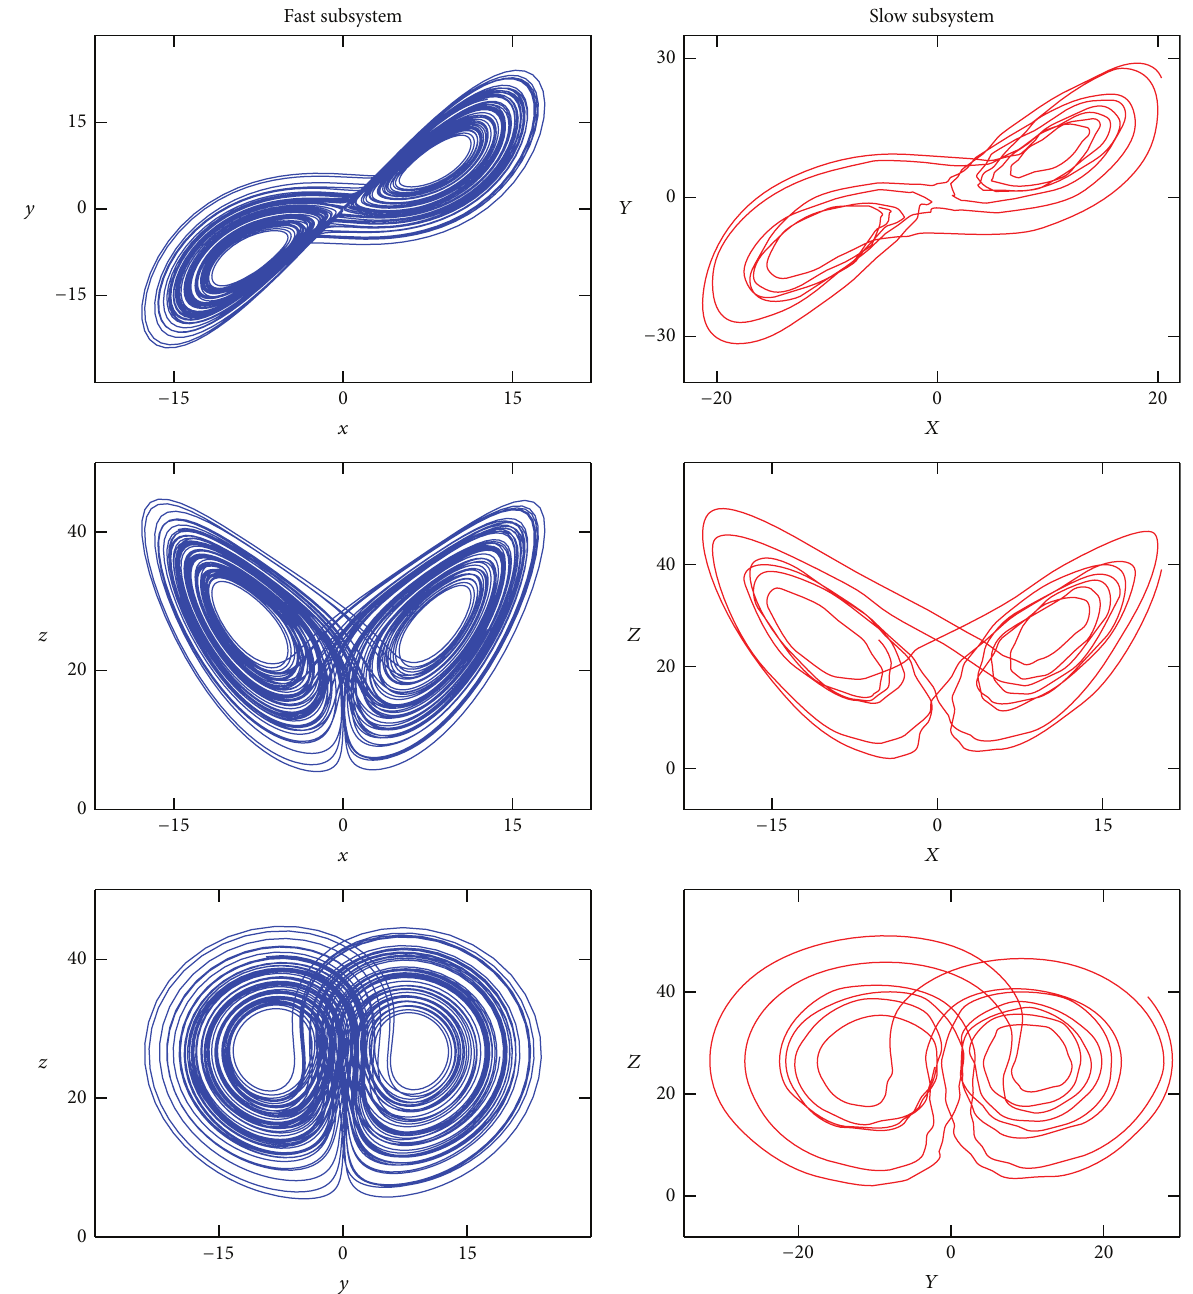
Figure 1: Phase portraits for fast and slow subsystems for 𝑐 = 0.15